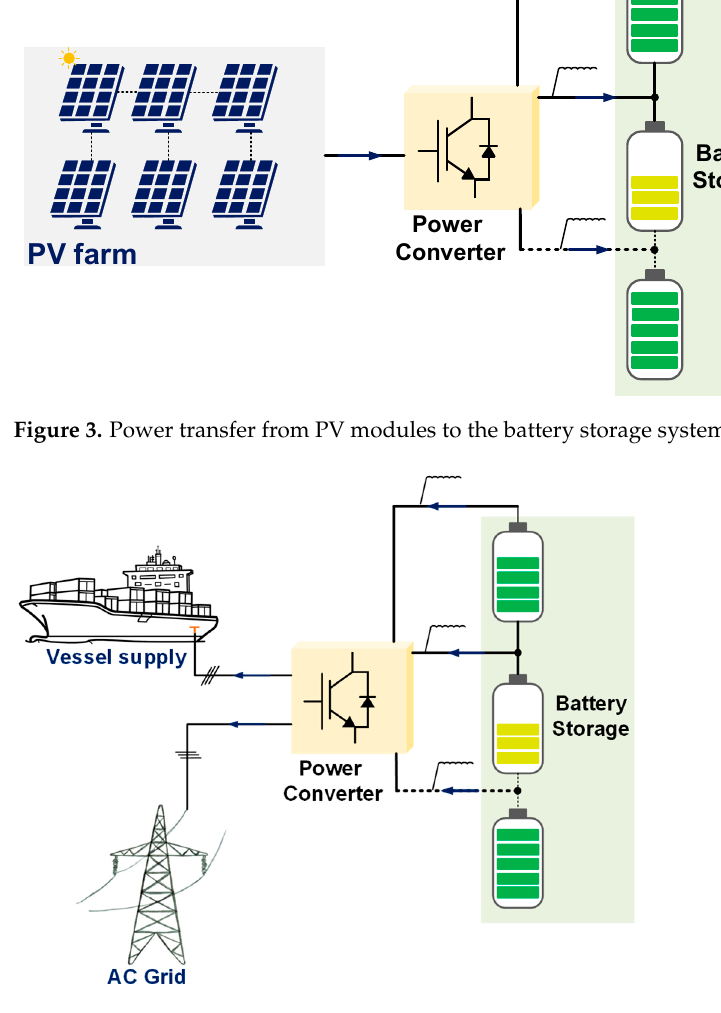
Figure 4. Power transfer from batteries to AC loads.